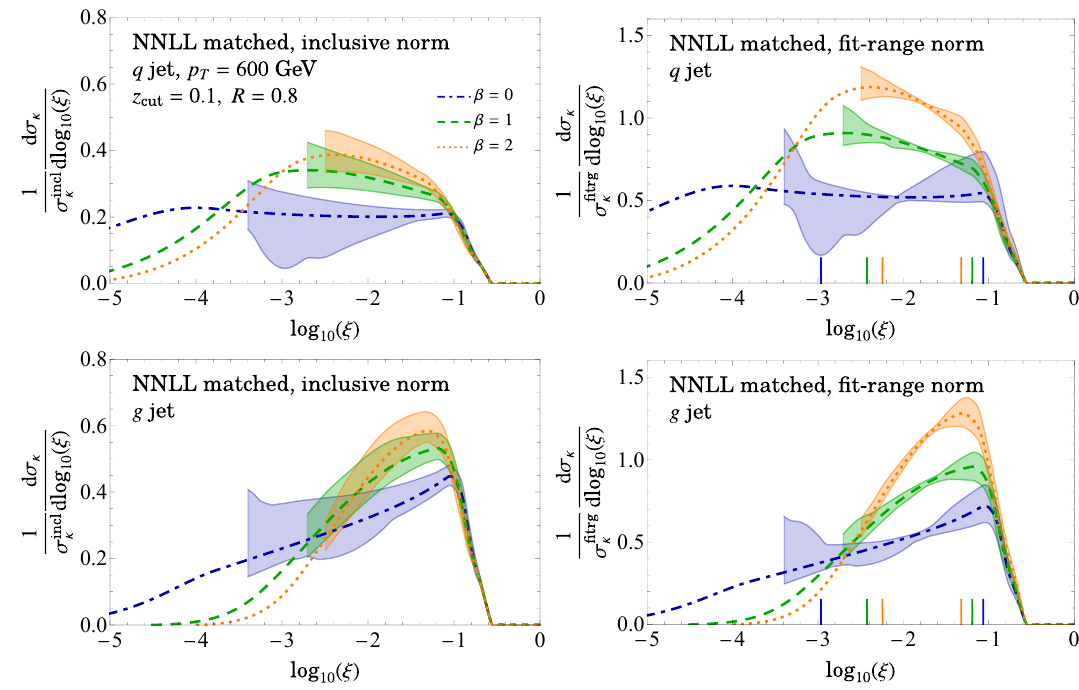
Figure 10 . An envelope of the profile variations for quark and gluon jets, for different values of β .